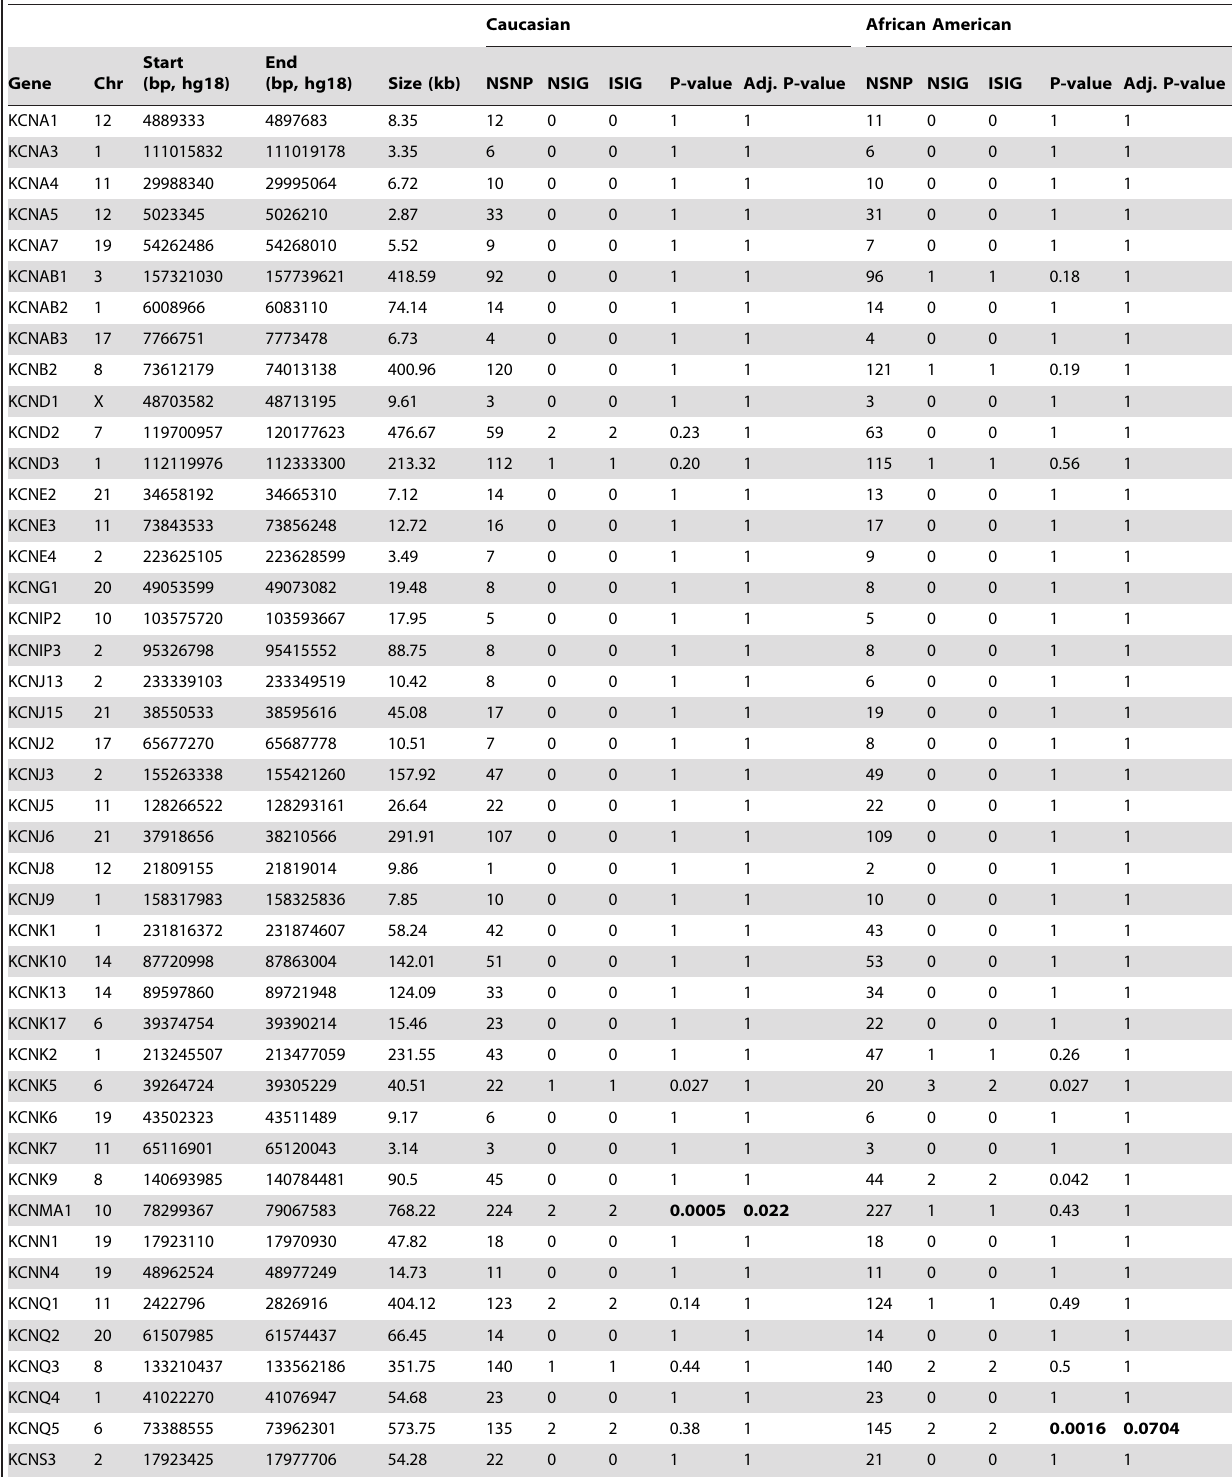
Caucasian African